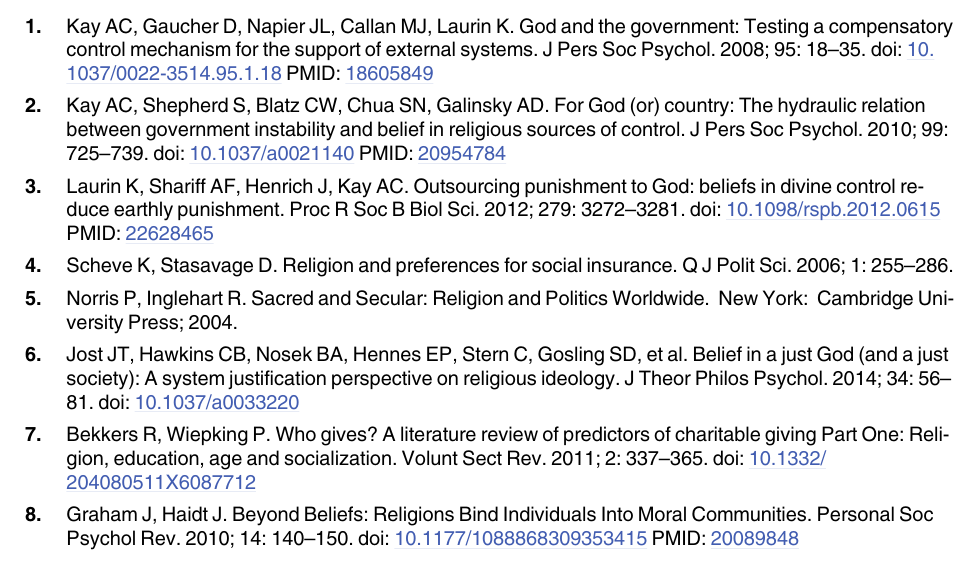
S1 Dataset. Supporting Data for Studies 1 – 3. S1 Fig. The Interactive Effect of Measured and Manipulated BGC on Support for Welfare State Expenditure among Israeli Jews (Study 1). The graph includes predictive margins with 95% confidence intervals. S2 Fig. The Interactive Effect of Education and Manipulated BGC on Support for Welfare State Expenditure among American Jews (Study 2). The graphs include predictive margins with 95% confidence intervals. S3 Fig. The Interactive Effect of Measured and Manipulated BGC on Support for Welfare State Expenditure among American Catholics (Study 3). The graph includes predictive mar- gins with 95% confidence intervals. S4 Fig. The Interactive Effect of Ideology and Manipulated BGC on Support for Welfare State Expenditure among American Catholics (Study 3). The graph includes predictive mar- gins with 95% confidence intervals. S1 File. The Interactive Effect of Education and BGC Primes on